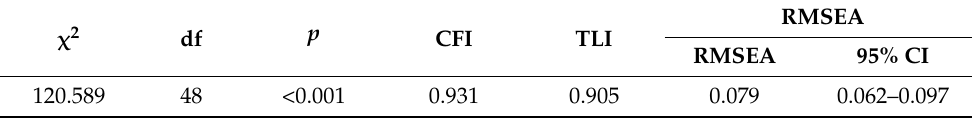
Table 2. Goodness-of-fit indices for the hypothesised